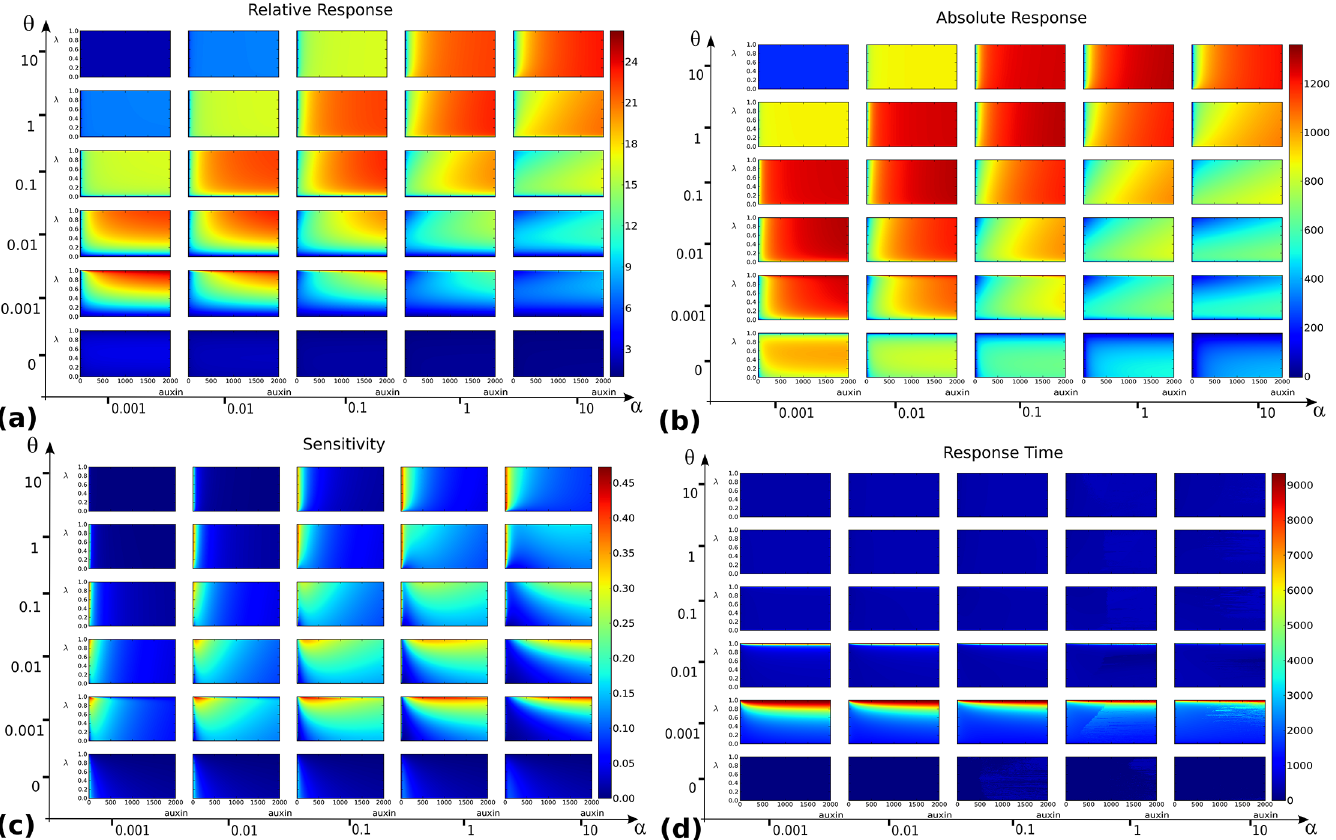
Fig 3. Output landscapes as functions of auxin level x (abscissae) and balance between the two core mechanisms, parametrized by λ (ordinates). (a) Relative response ρ rel ( x , λ ). (b) Absolute response ρ abs ( x , λ ). (c) Sensitivity σ ( x , λ ). (d) Response time τ ( x , λ ). For each of these functions, the grid of values ( α , θ ) Є {0.001,0.01,0.1,1,10}×{0,0.001,0.01,0.1, 1,10}is considered and for each landscape ( x , λ ) span a 200×200 regular grid on the rectangle [0, 2000]×[0, 1].